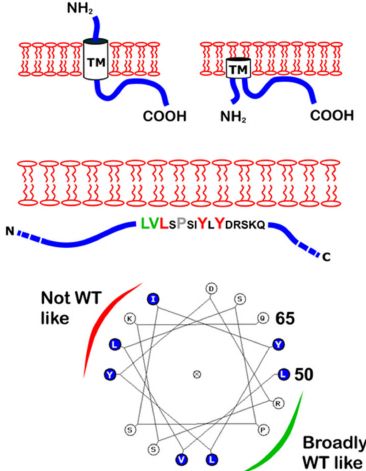
Figure 6. Predicted topological models of E and the EPTM peptide. Above : Two of the suggested topologies of E are shown with TM, N- and C-termini indicated. Middle : The EPTM peptide is shown within the C-terminal region. Mutated residues are enlarged and coloured according to the level of membrane repartitioning observed. Below : A helical wheel depiction of the EPTM peptide with a suggested interpretation of sidedness with respect to membrane